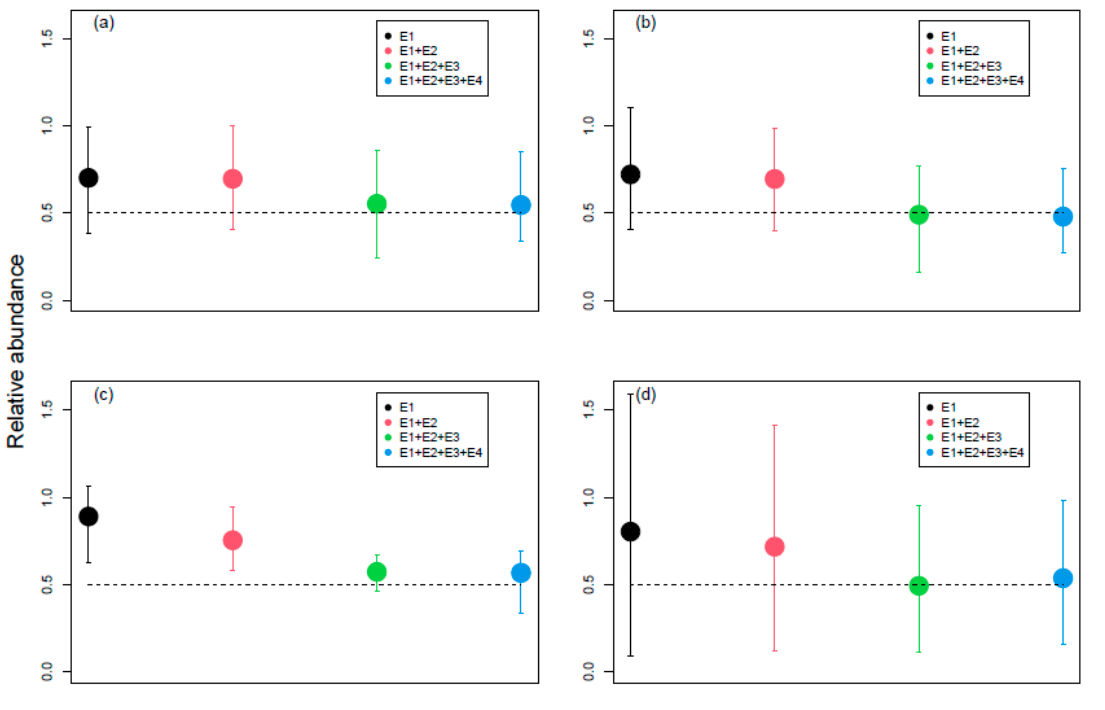
Figure 5. Relative population abundances of the four species in the second simulation set, i.e., where effect sub-models were sequentially added. Average populations are calculated over the exposure time (5 years), the ratios of over-time averages are calculated for each replicate, and then ratios are averaged over 40 replicates. The bars show the maximum and minimum value of the ratio among the 40 replicates. ( a ) Topeka shiner (EMF = 5); ( b ) Devils River minnow (EMF = 5); ( c ) Spikedace (EMF = 7); ( d ) Humpback chub (EMF = 8).